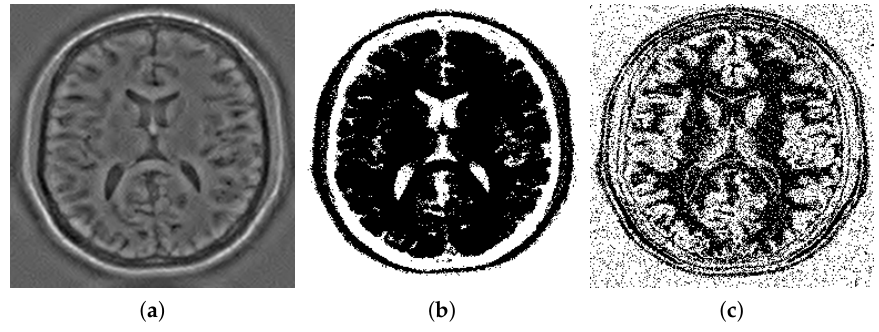
Figure 2. More details about the above MRI image segmentation and the gradient descent setup: ( a ) the edges to be preserved, ( b ) initial guess for φ 1 , ( c ) initial guess for φ 2 (percentiles used for computing the initial guess: 15%, 38%, 61%,